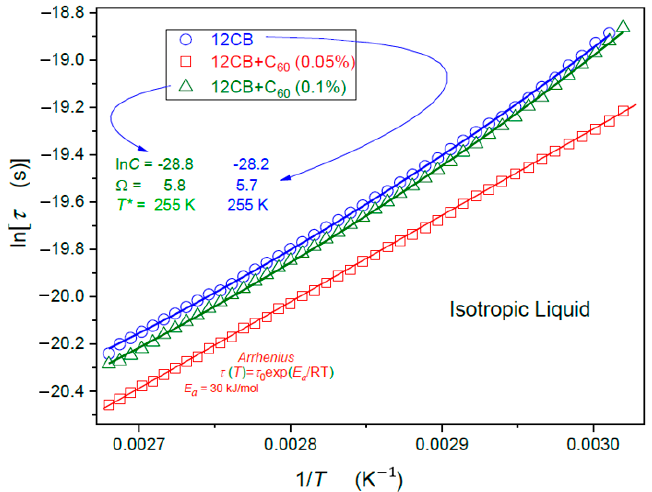
Figure 5 Figure 5. The evolution of primary relaxation times in the isotropic liquid phase of 12CB and its